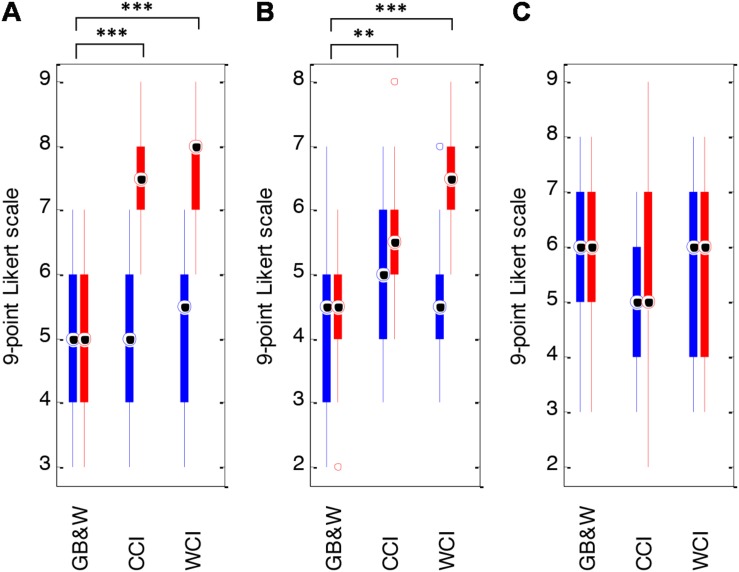
Mean SAM scores: (A) valence, (B) arousal, and (C) dominance for GB&W, CCI, and WCI for an average of 14 participants per condition. Blue boxes = pre-SAM scores and red boxes = post-SAM scores. Asterisks indicate the significance level (∗∗p < 0.01 and ∗∗∗p < 0.001).